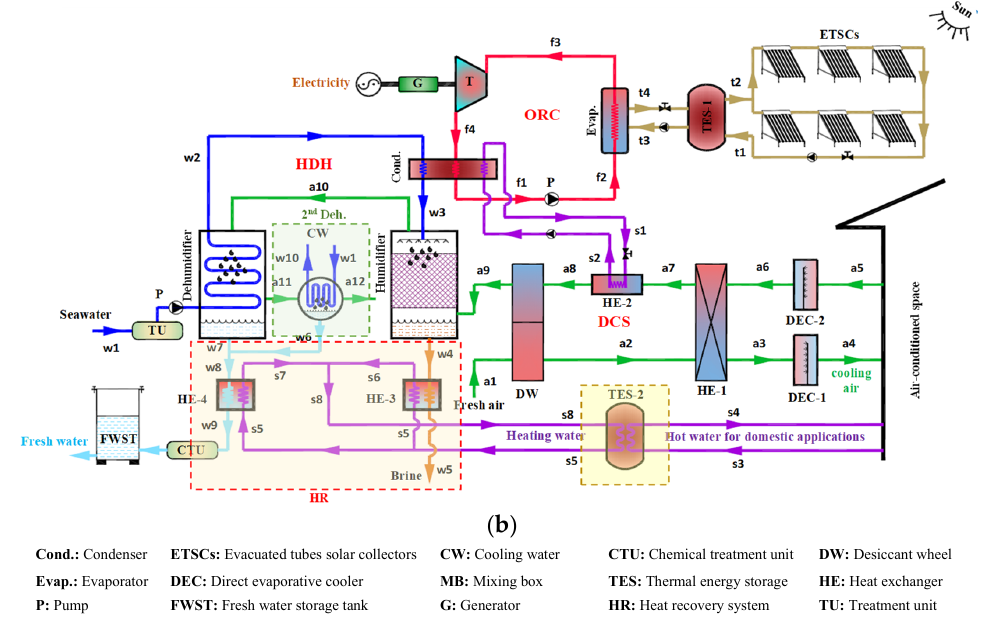
Figure 1. Schematic diagram of proposed multi-generation systems: ( a ) MGS-I; ( b ) MGS-II. In the solar field cycle, evacuated tube solar collectors are used to charge the TES-1 tank when it is sunny (state points t1 and t2), which is then used to provide the system with constant energy demand through the ORC evaporator both during the day and at night (state points t3 and t4). The ORC cycle uses an evaporator to transfer heat from the thermal oil to the ORC fluid, which is then expanded through the turbine to produce electricity using a linked generator after becoming superheated to (f3) and evaporating. To maintain the same temperature at the state points (a8 and w3), the ORC fluid exits the turbine at (f4). It is delivered to the triple channel heat exchanger’s condenser, where it is condensed at (f1), and waste heat is recovered for the DCS and HDH units. The cycle is finished by pumping the ORC liquid to (f2) and then back to the evaporator. The ORC fluid leaves the turbine at position (f4). It is transported to the triple channel heat exchanger’s condenser, where it condenses at position (f1) and recovers waste heat for the DCS and HDH units to maintain the temperature at state points (a8 and w3). To complete the cycle, the ORC liquid is subsequently piped to (f2) and finally pushed back to the evaporator. Process air enters the desiccant wheel (DW) at (a1) in the air cycle, where it is dehu- midified and heated to (a2) before passing via the heat exchanger (HE-1), where it is cooled to (a3). The process air enters the direct evaporative cooler (DEC-1), which is cooled and humidified at (a4) before entering the air-conditioned chamber. The return air from the conditioned space at (a5) is directed to the direct evaporative cooler (DEC-2), where it is cooled and humidified before leaving at (a6). The heat exchanger (HE-1) is then used to heat the return air (a7). The return air (regeneration air) then passes through a heat ex- changer (HE-2) to recover some of the waste ORC condenser heat to reach the necessary regeneration temperature (a8) before passing through DW (reactivation part), where it is cooled and humidified to the required regeneration temperature (a9). Finally, the HDH system delivers the humidified and cooled regeneration air from the DW to the humidifier, where it is humidified and cooled at (a10) before being given to the dehumidifier and is dehumidified at (a11). Figure 2a for the basic multi-generation system shows the psychrometric cycle of the air (MGS-I).